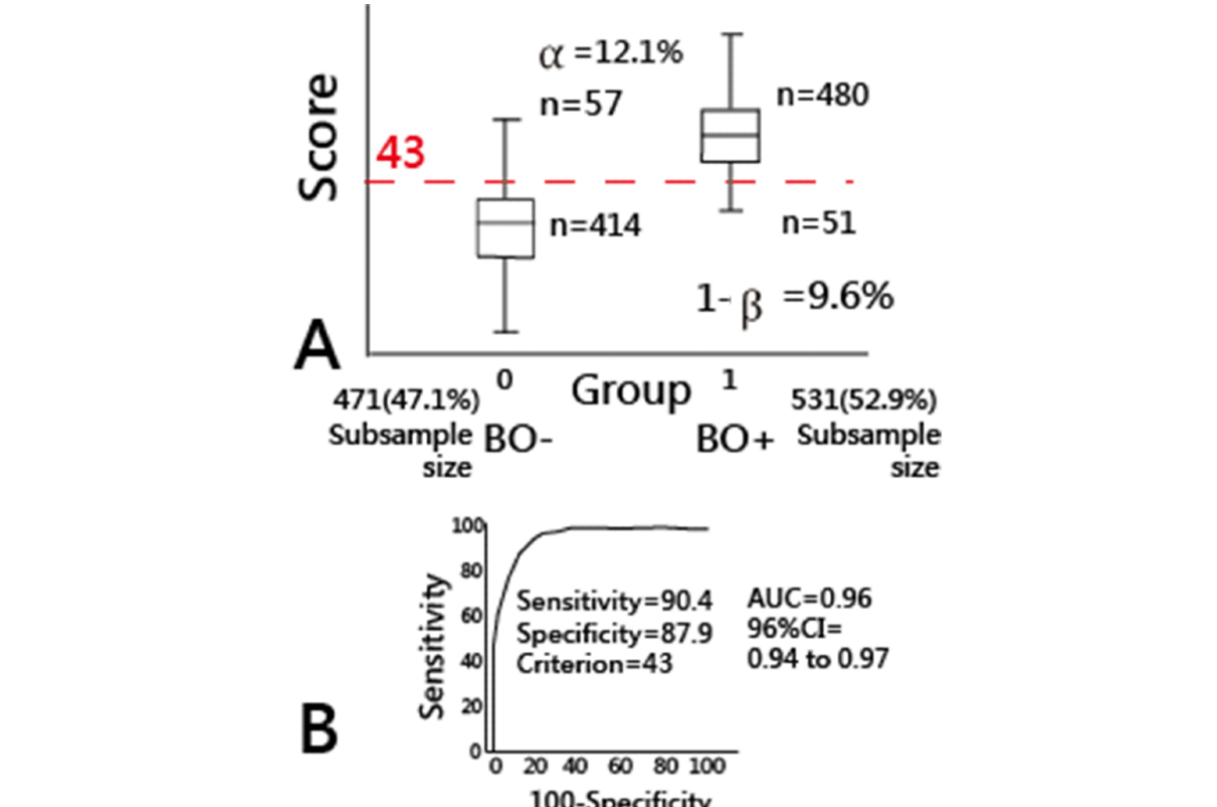
Tasks to Compare the Accuracy Between Modes Comparison of Prediction Accuracies in Two Modes The 20-item model yields a higher accuracy rate (0.95) with an AUC 0.98 (95% CI 0.97-1.00) higher than that of the 20-item model with an accuracy of 0.95 and an AUC 0.97 (95% CI 0.96-0.99) based on the 1002 cases. Table 2. Three scenarios applied to convolutional neural network for the prediction of nurse burnout (n=1002).